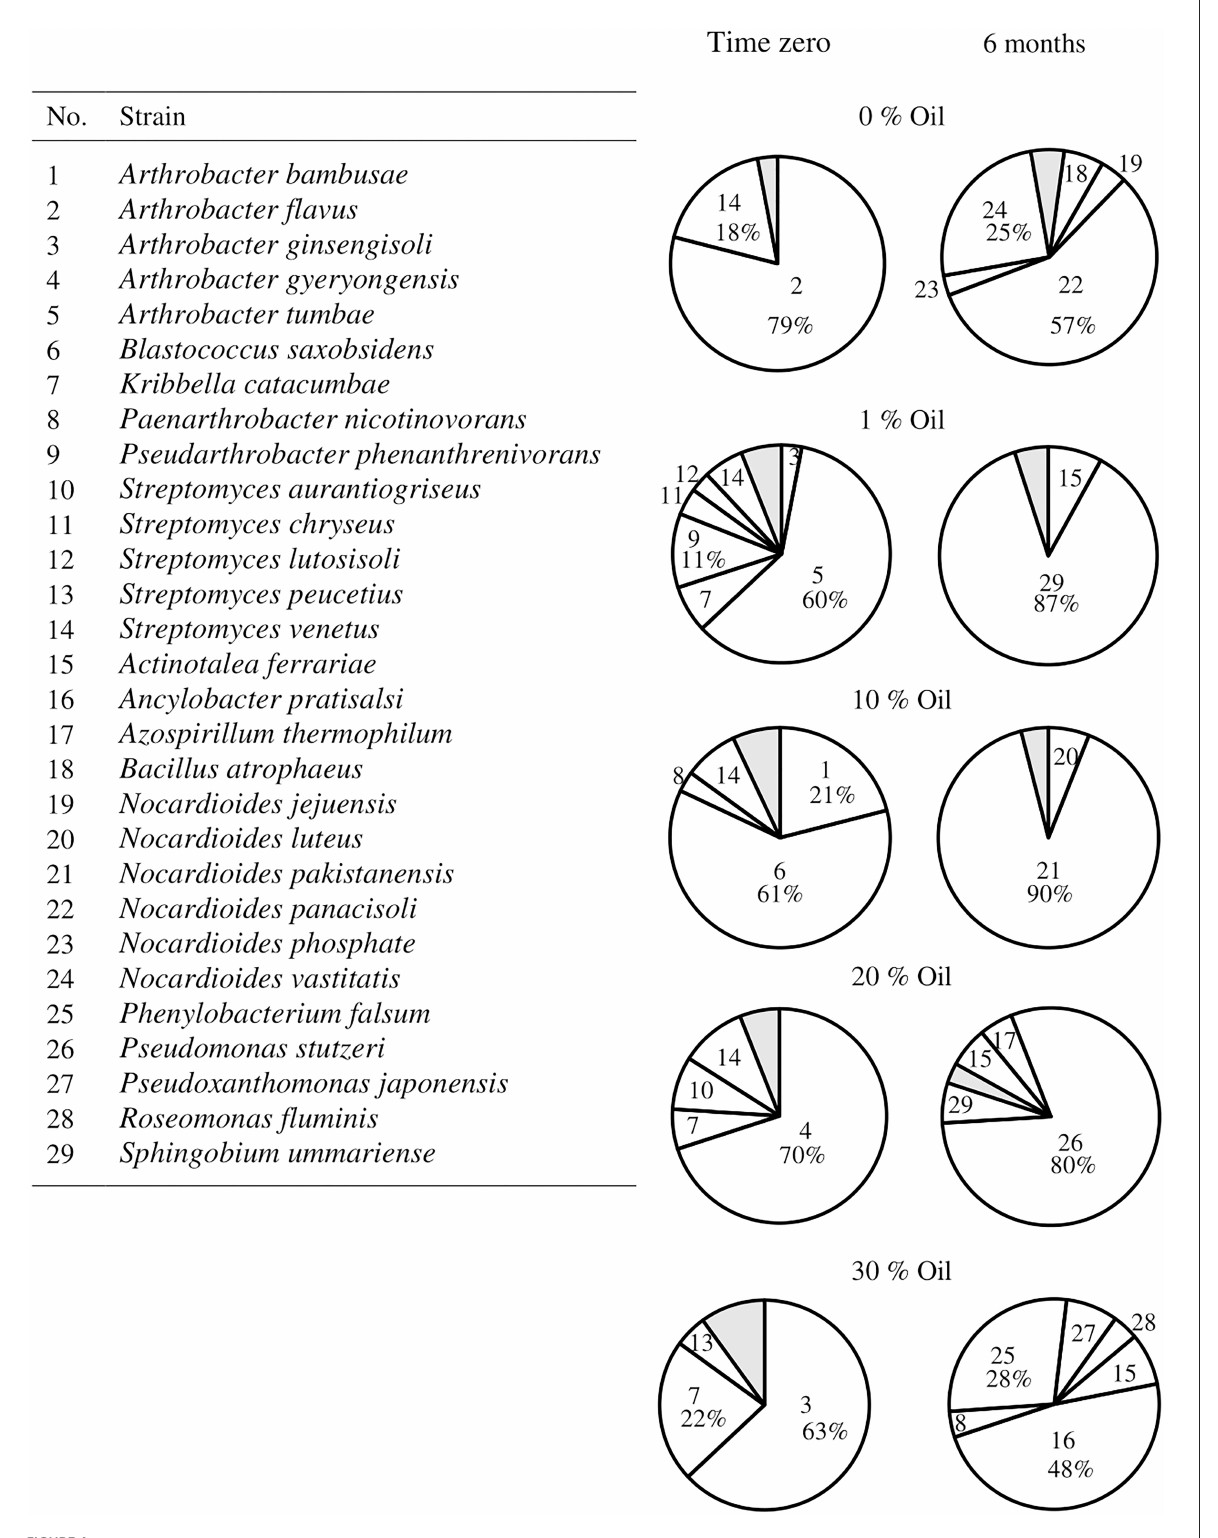
FIGURE4 Hydrocarbonoclastic microbial communities in the desert soil samples polluted with different concentrations of crude oil at time zero and after 6 months. Shaded areas comprise minor organisms ( < 5% occurrence), refer to Supplementary Table S4 for their